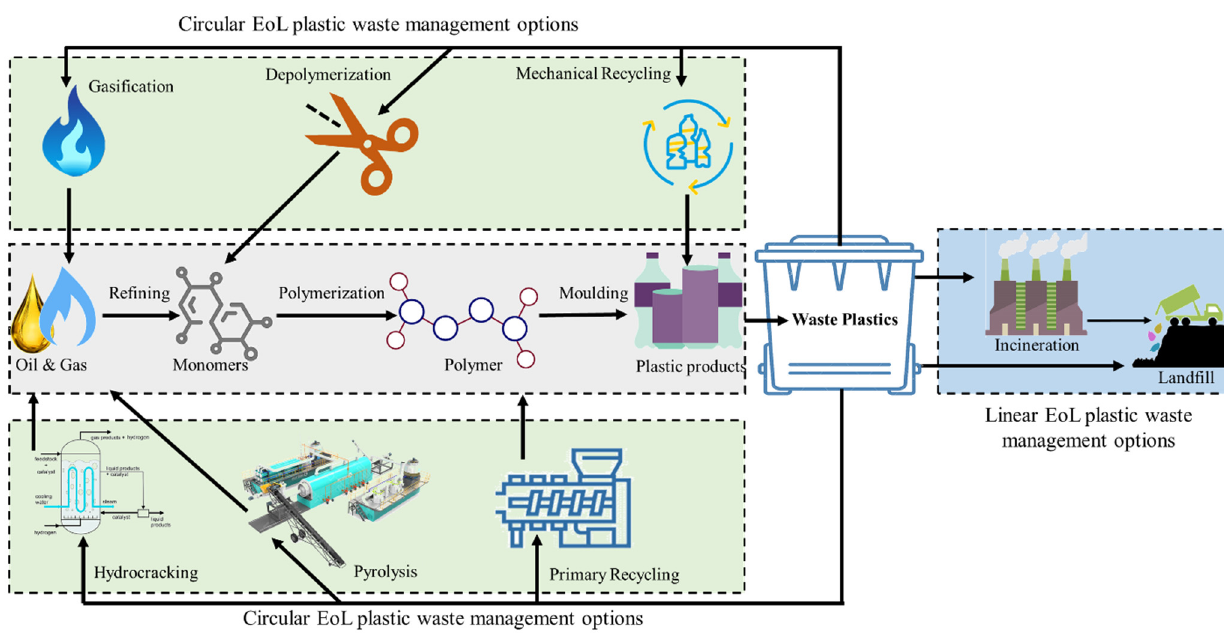
Figure 2. A comparative analysis of linear and circular EOL waste plastics management techniques.